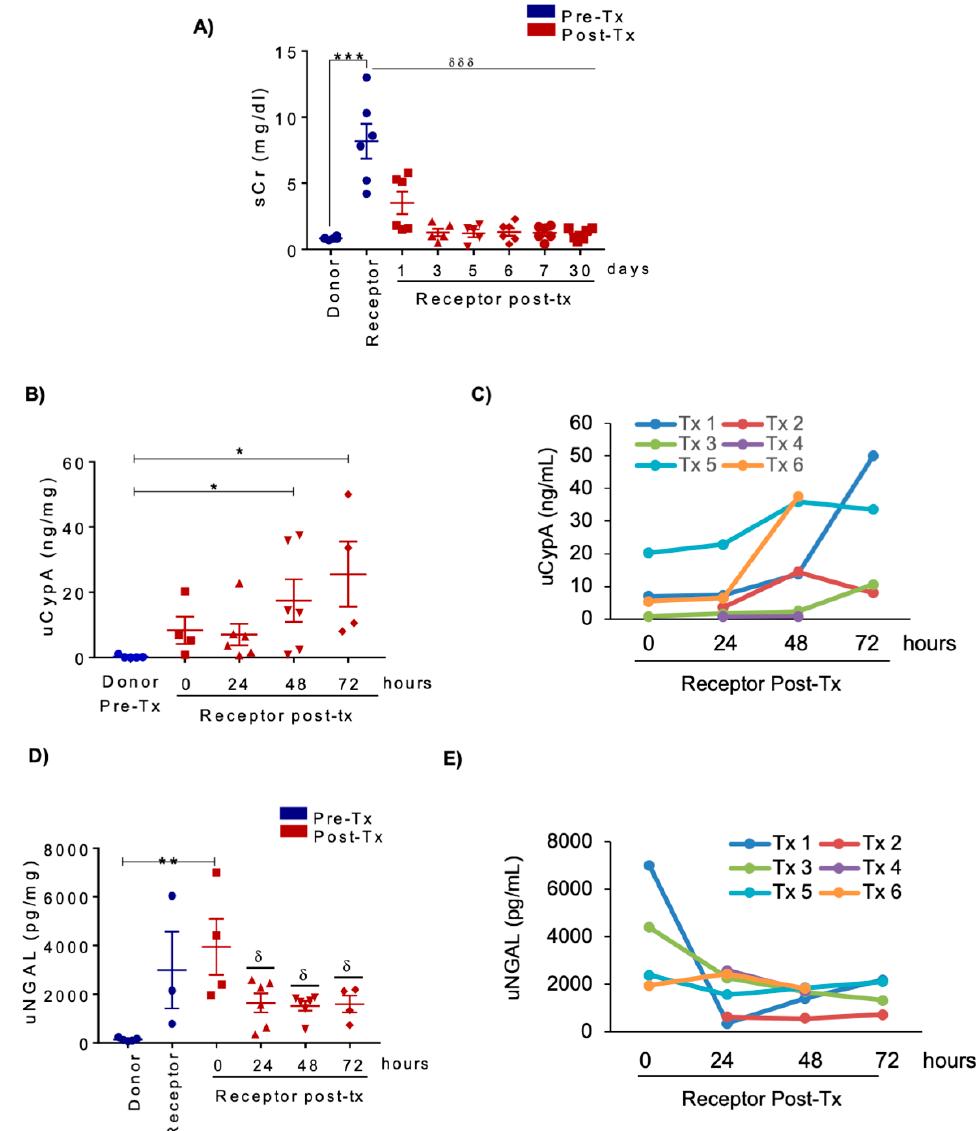
Figure 8. uCypA levels are increased after living KT. ( A ) sCr levels decreased following KT. Bars represent mean ± SEM. *** p < 0.05 vs. donor; δδδ p < 0.001 vs. receptor pre-transplant. ( B ) By contrast, uCypA levels increased following KT in recipients compared with donor urine. Bars represent mean ± SEM. * p < 0.05. uCypA is expressed as urinary CypA: urinary creatinine ratio. ( C ) Time-course of uCypA levels in individual patients shows a peak at 24–48 h after surgery in most patients. ( D ) uNGAL levels decreased from time zero after surgery in KT recipients. uNGAL is expressed as urinary NGAL: urinary creatinine ratio. Bars represent mean ± SEM. ** p < 0.01. ( E ) Time-course of uNGAL levels in individual patients shows a decrease after surgery in most patients.